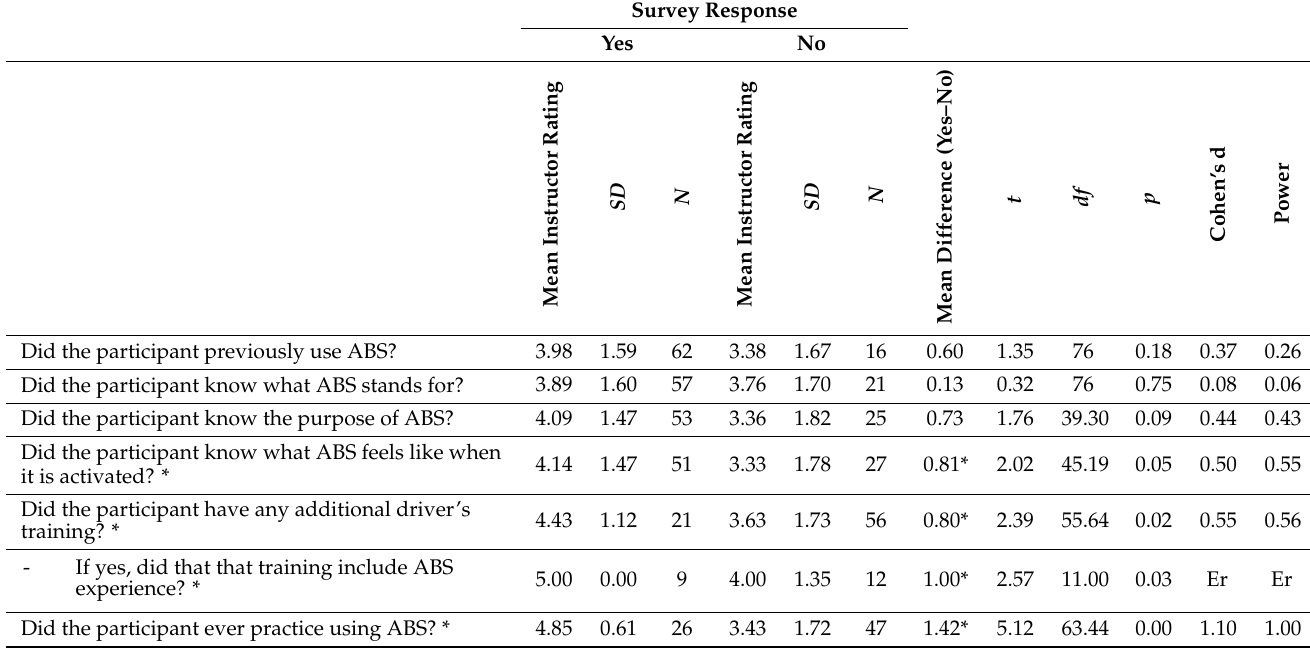
Table 3. Average instructor ratings for run one for all participants based on their knowledge of ABS and previous experience using ABS.